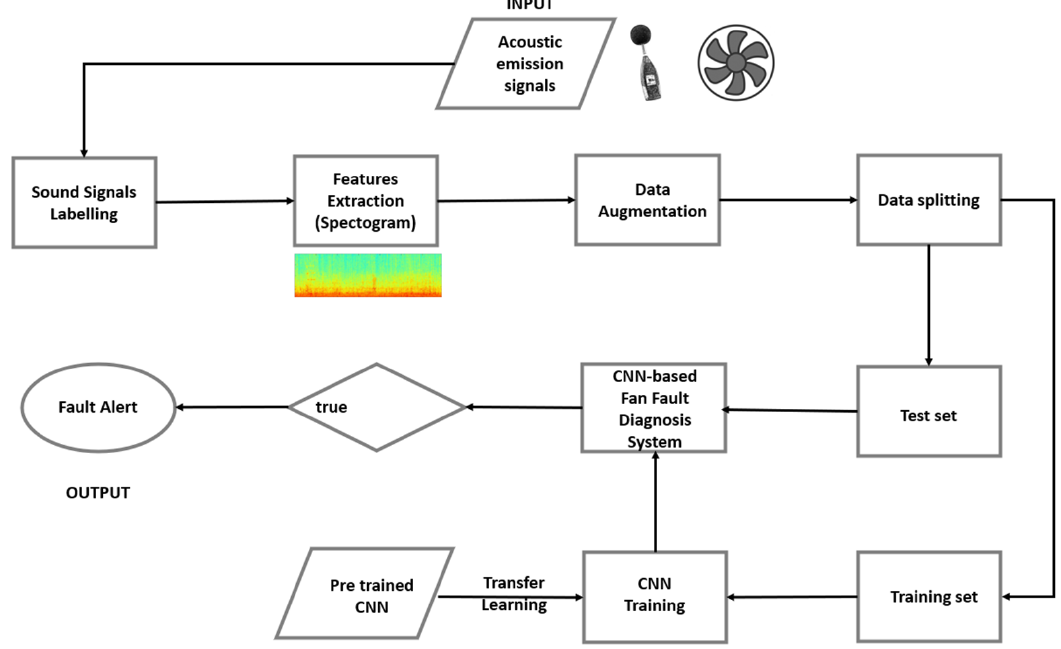
Figure 1. Flow chart of the automated system for fan fault diagnosis.